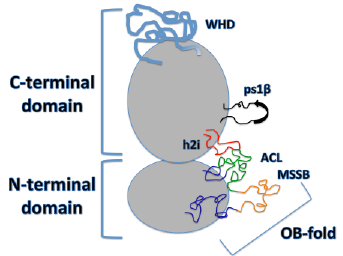
Figure 2. One individual MCM (minichromosome maintenance complex) subunit. Primary DNA-interacting features are shown. The winged helix domain (WHD) in blue; the pre-sensor-1- β hairpin (ps1 β ) in black; the helix-2-insert (h2i) in red; the OB-fold of the C subdomain of the N-terminal domain (NTD), with the allosteric communication loop (ACL) in green and the MCM single-stranded DNA binding motif (MSSB) in orange. The Mcm2 subunit of Saccharomyces cerevisiae does not contain a winged helix domain [11].